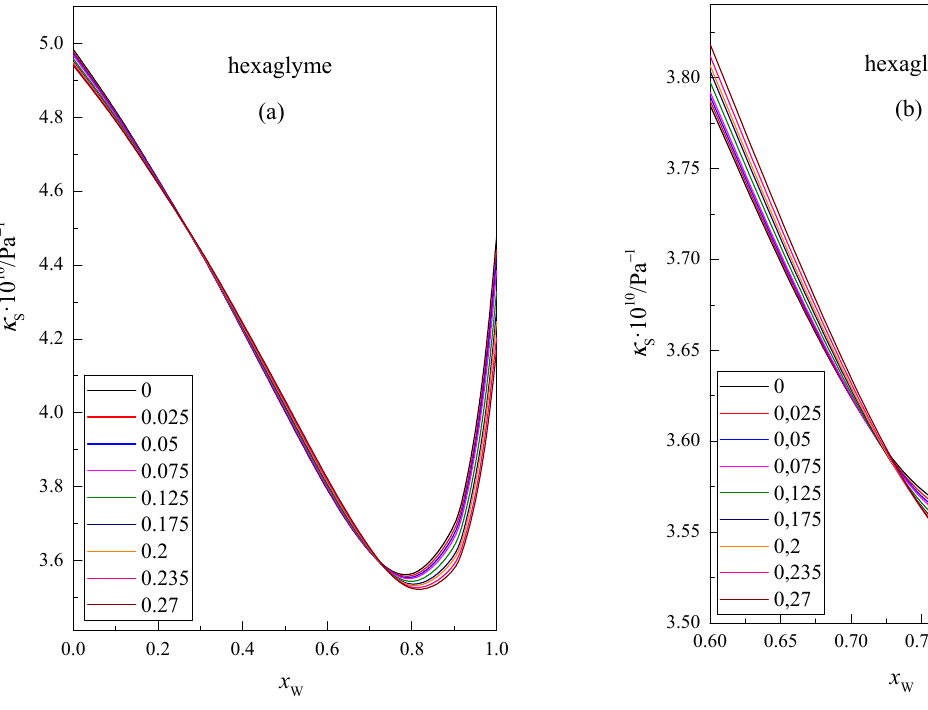
Figure 4. Dependence of the isentropic compressibility κ S of isomolal solutions of hexaglyme in the DMF + W mixed solvent in relation to the mole fraction of water, x W , at 298.15 K, ( a ) 0 ≤ x W ≤ 1, ( b ) 0.6 ≤ x W ≤ 0.9, ( c ) 0.2 ≤ x W ≤ 0.4.